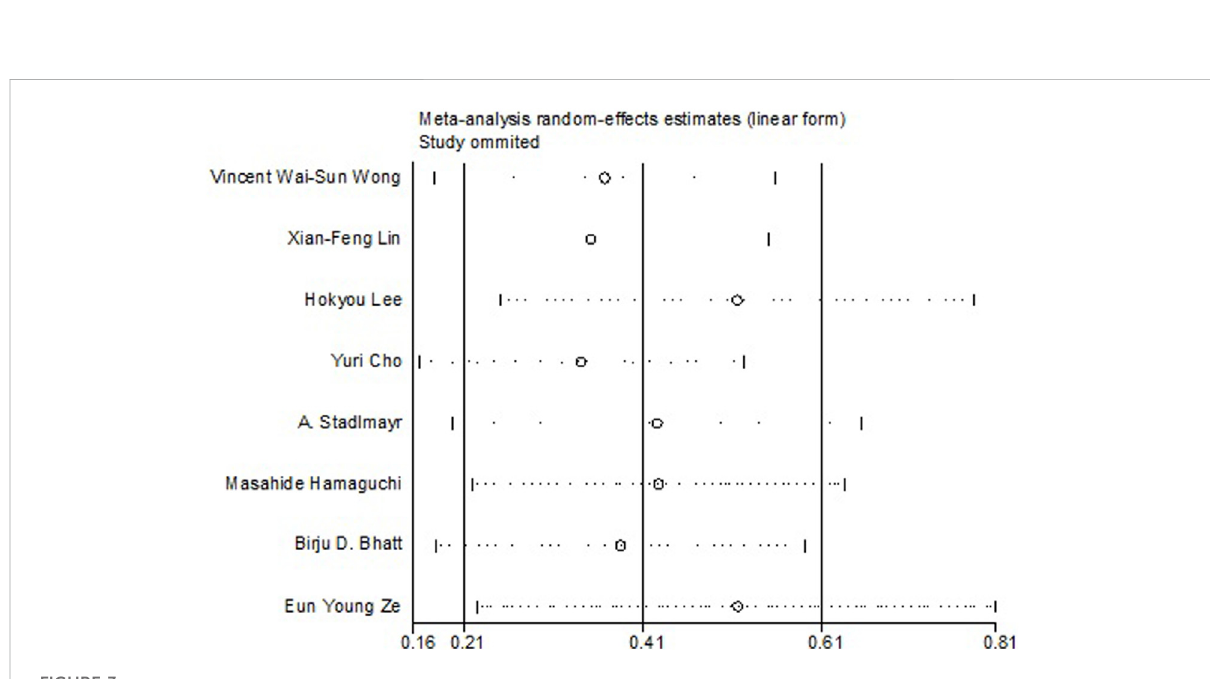
FIGURE 3 Sensitivity analysis showing the effect of NAFLD on CRC in eight